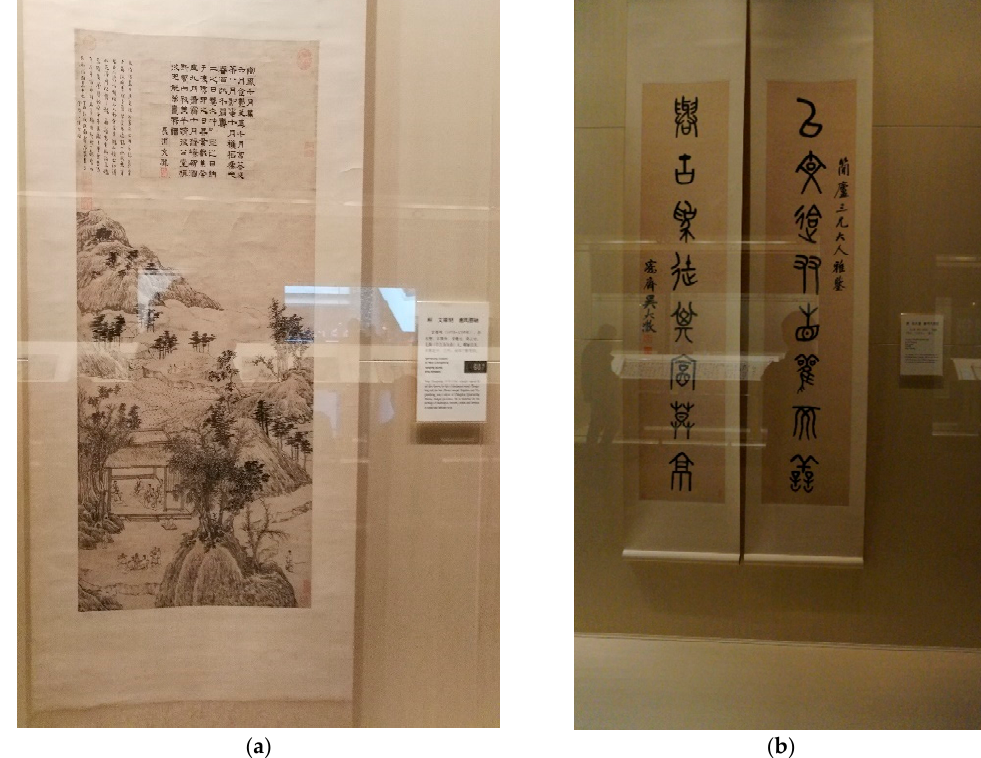
Figure 5. Reflected glare in the exhibition hall of Chinese calligraphy and painting works. ( a ) First